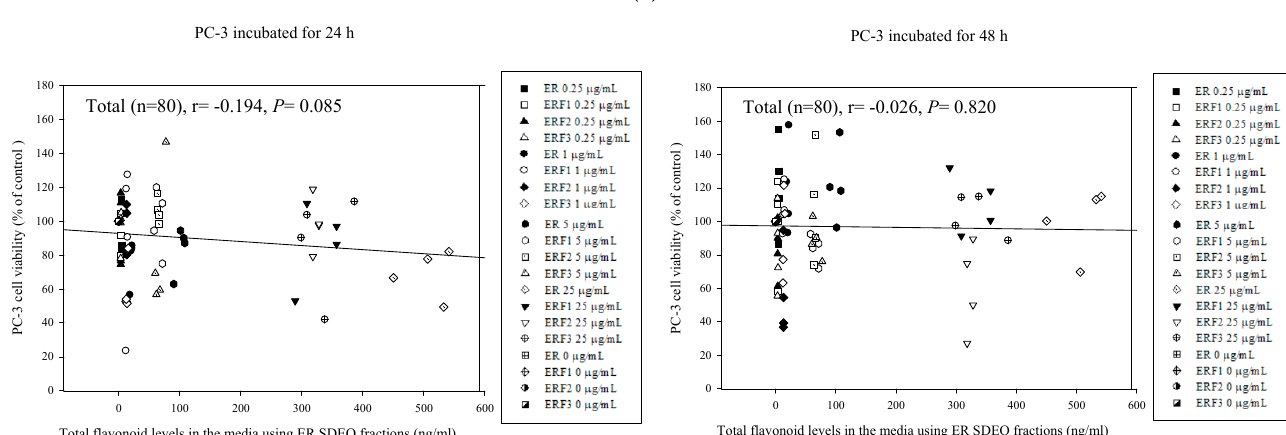
Figure 9. The associations between total polyphenol ( a ) as well as flavonoid contents ( b ) in the media and their corresponding PC-3 cell viabilities treated with SDEO samples for 24 and 48 h, respectively. The correlation was expressed by Pearson product–moment correlation coefficient (r).